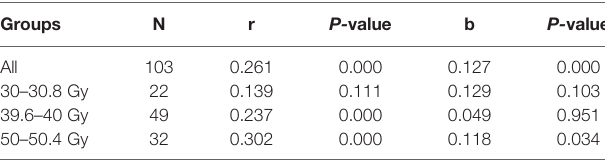
TABLE 4 | Correlation and regression between dose intervals and D HU.